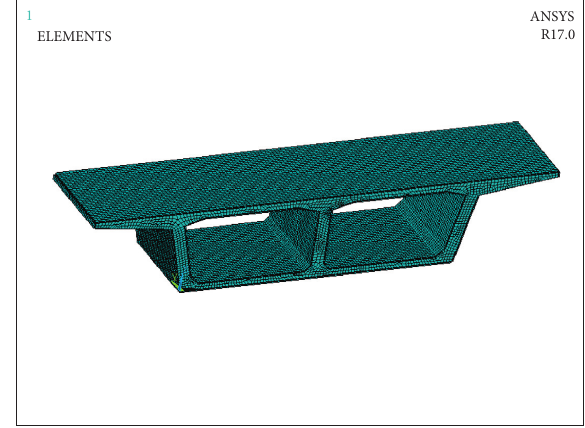
Figure 13: Box girder finite element